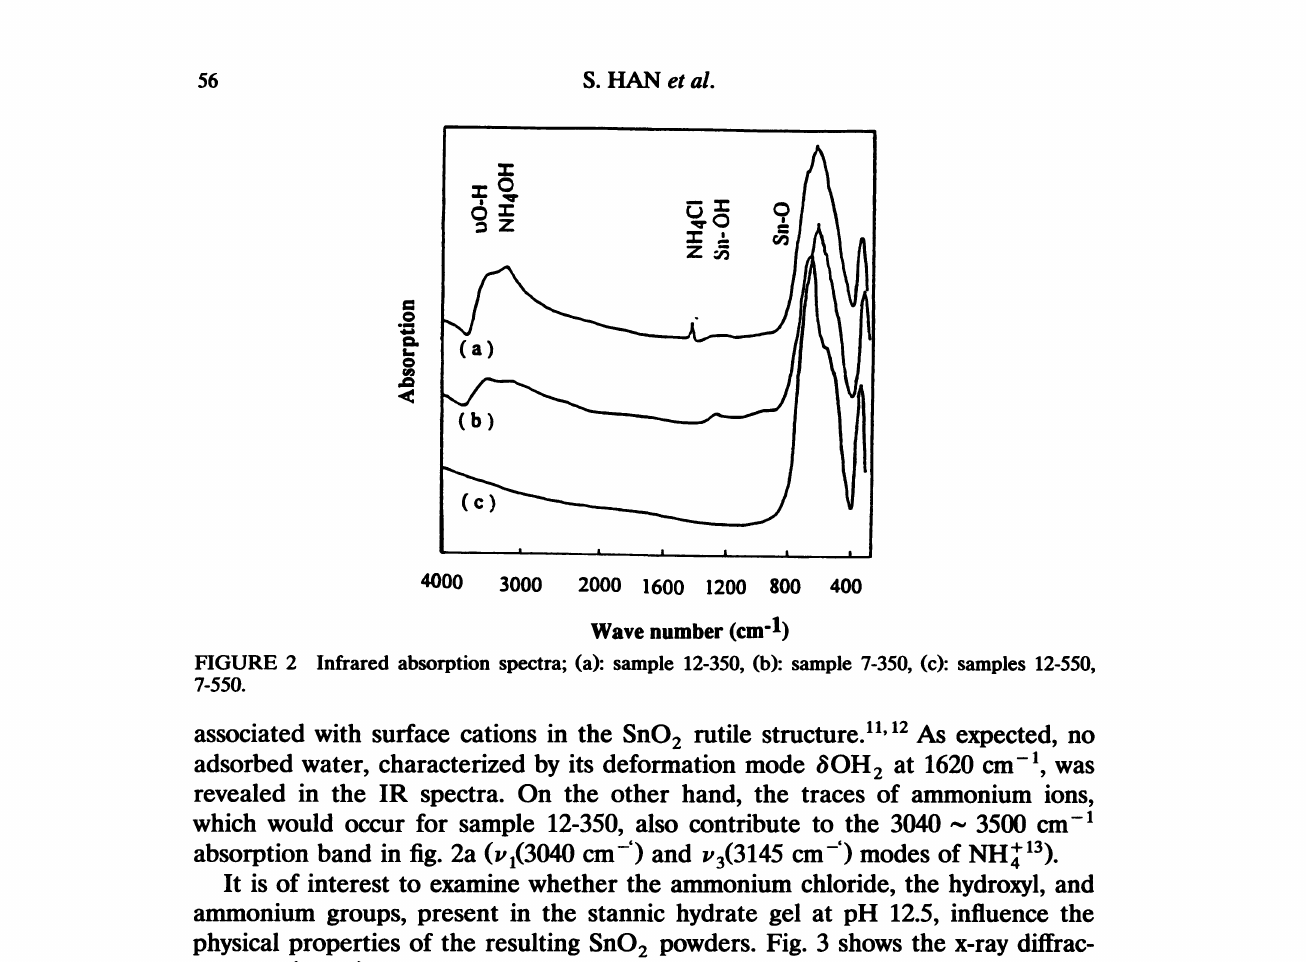
4000 3000 2000 1600 1200 800 400 Wave number (cm "1) FIGURE 2 Infrared absorption spectra; (a): sample 12-350, (b): sample 7-350, (c): samples 7-550.